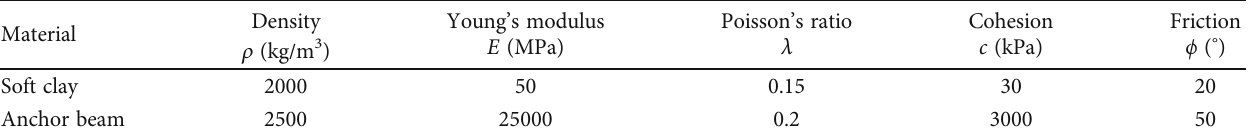
Table 1: Material properties of the model.